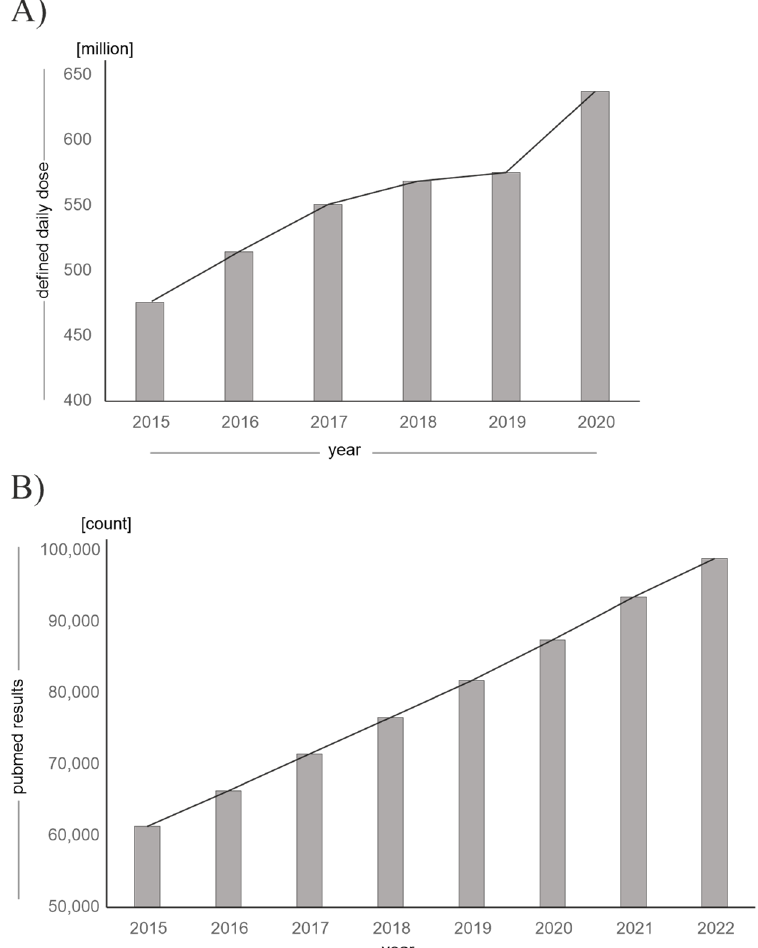
Figure 2. Increasing clinical and environmental relevance of vitamin D and its analogues. ( A ) De- fined daily dose (DDD) of vitamin D and vitamin D analogues prescribed in Germany, which has been increasing since 2015 until 2020. (Source: annual “Arzneiverordnungs-Report” in the publish- ing company “Springer”, data given in million DDD). ( B ) Increasing number of publications on PubMed for the search term “vitamin D”, “vitamin D analogues” or “vitamin D derivatives” as of 30 December 2022.